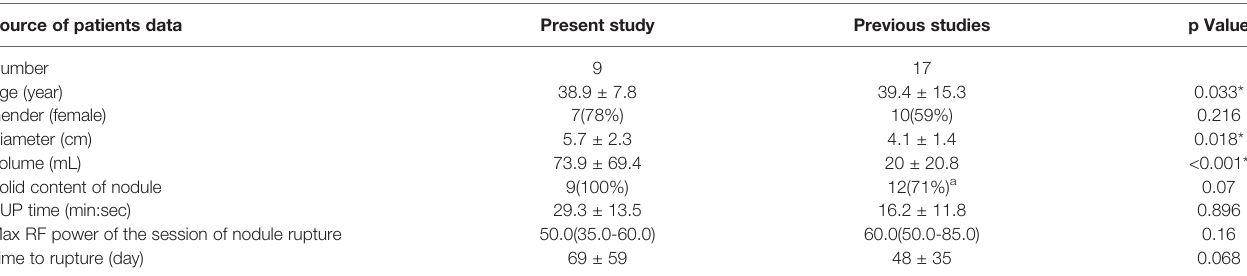
TABLE 5 | Comparison of patient characteristics of our study and other previous studies. Source of patients